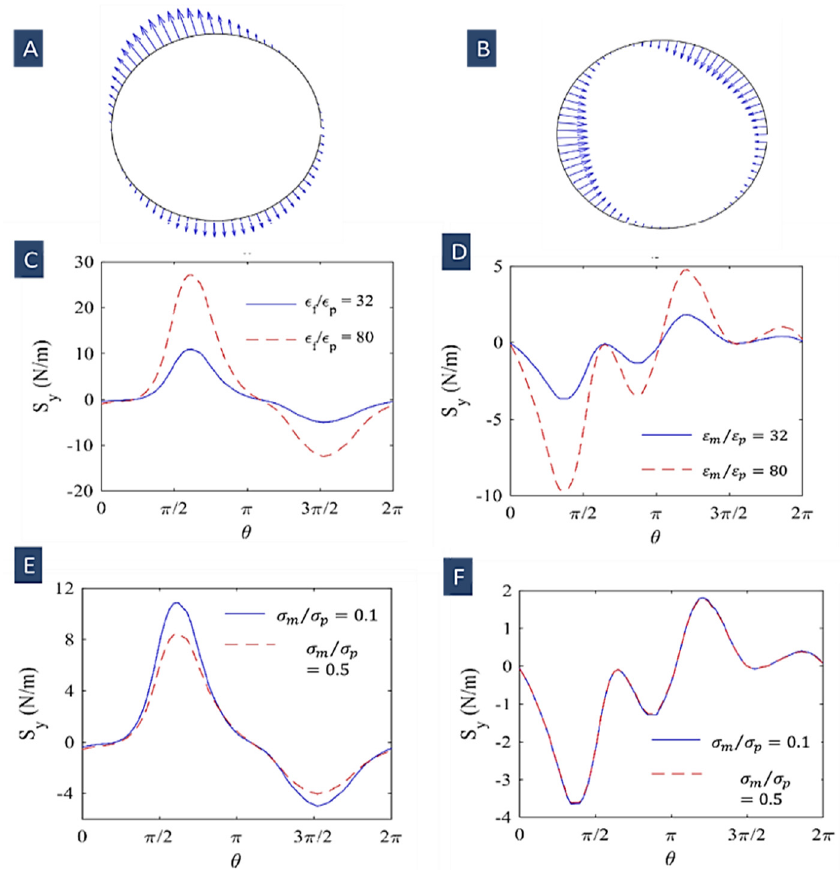
Figure 3. ( A ) low-frequency tensile stress on the cell surface in a non-uniform electric field for σ p = 10 − 3 s / m , ε p = 2.5 ε 0 , σ m = 10 − 4 s / m and ε m = 80 ε 0 (10 kHz); ( B ) high-frequency compressive stress on the cell surface in a non-uniform electric field for the same electrical properties (10 MHz) (Reprinted with permission from [84]. Copyright 2020, Springer Nature); ( C ) the magnitude of electric stresses (y-component) and effect of suspension permittivity in the frequency of 10 kHz; ( D ) the magnitude of electric stresses and effect of suspension permittivity in the frequency of 10 MHz; ( E ) the magnitude of electric stresses and effect of suspension conductivity in the frequency of 10 kHz; ( F ) the magnitude of electric stresses and the effect of suspension conductivity in the frequency of